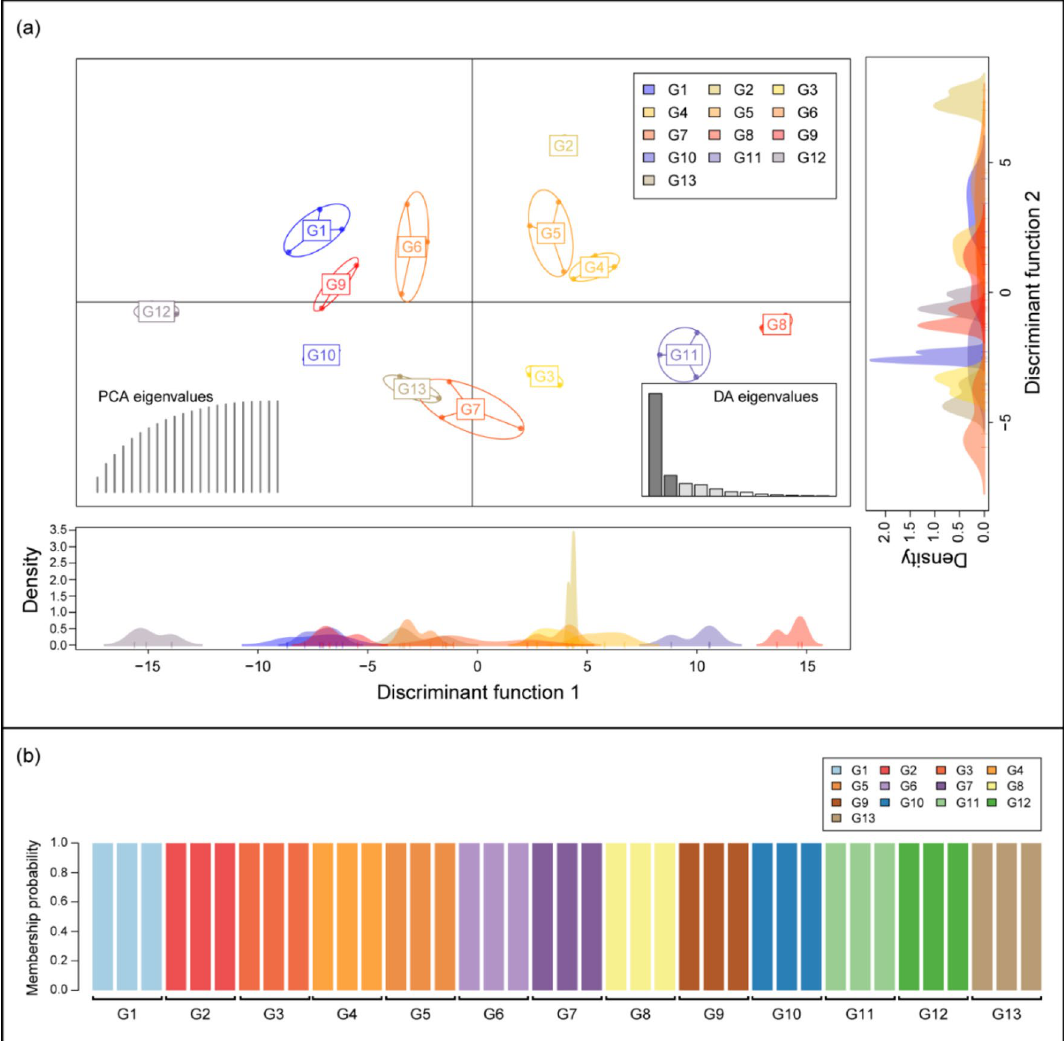
Figure 3. Results of population clustering by discriminant analysis of principal components (DAPC): ( a ) the discriminant functions 1 (DF1) explained 61.30% of the genetic variation in yellow-legged hornets from 13 sites and DF 2 explained 12.38% of the variation. Each node represents the genotype of a yellow-legged hornet connected to a centroid was assigned based on the clustering of the DAPC scores. ( b ) Membership probability of DAPC determined that the sampled individuals were optimally clustered into 13